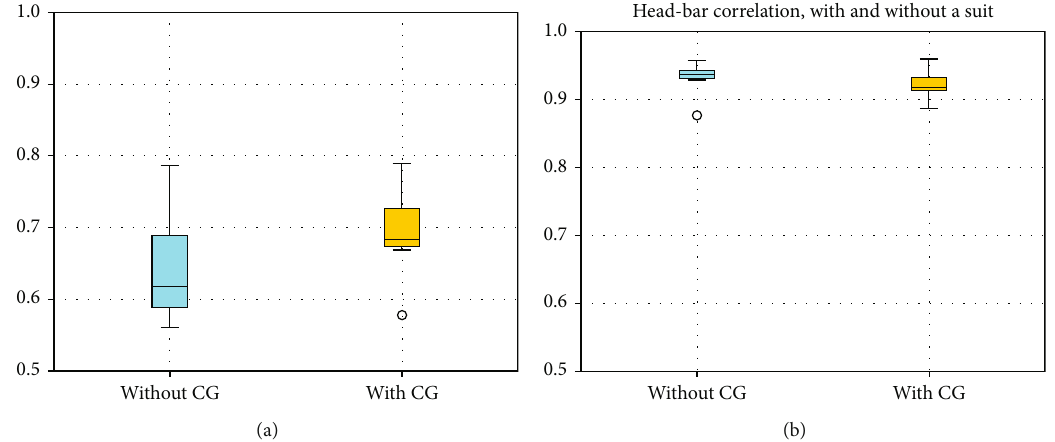
Figure 3: P ’ s bar x TW bar correlation (3a) and P ’ s head x P ’ s bar correlation during the tightrope walker (TW)